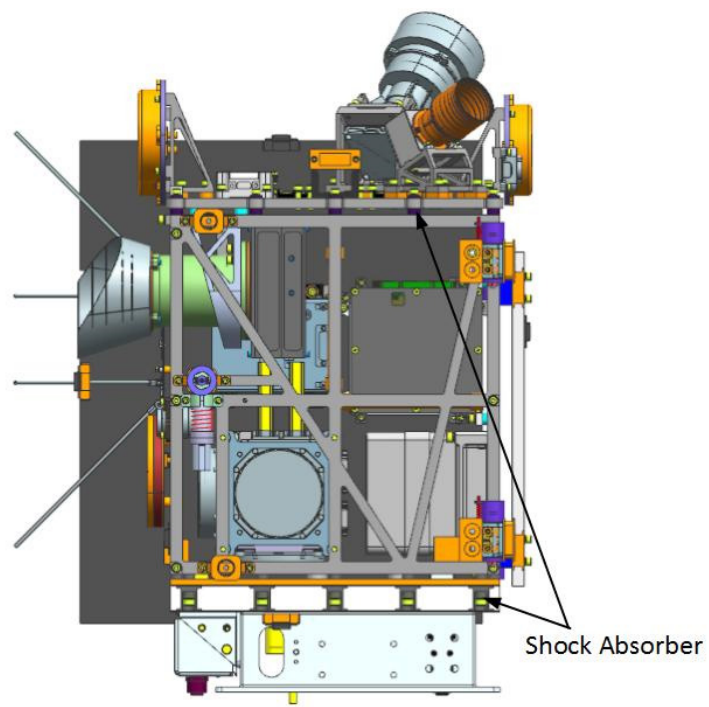
Figure 3. Shock absorbers in the Luojia 1-01 satellite (without the side solar panels). Table 6. Parameters of TCS design requirements in